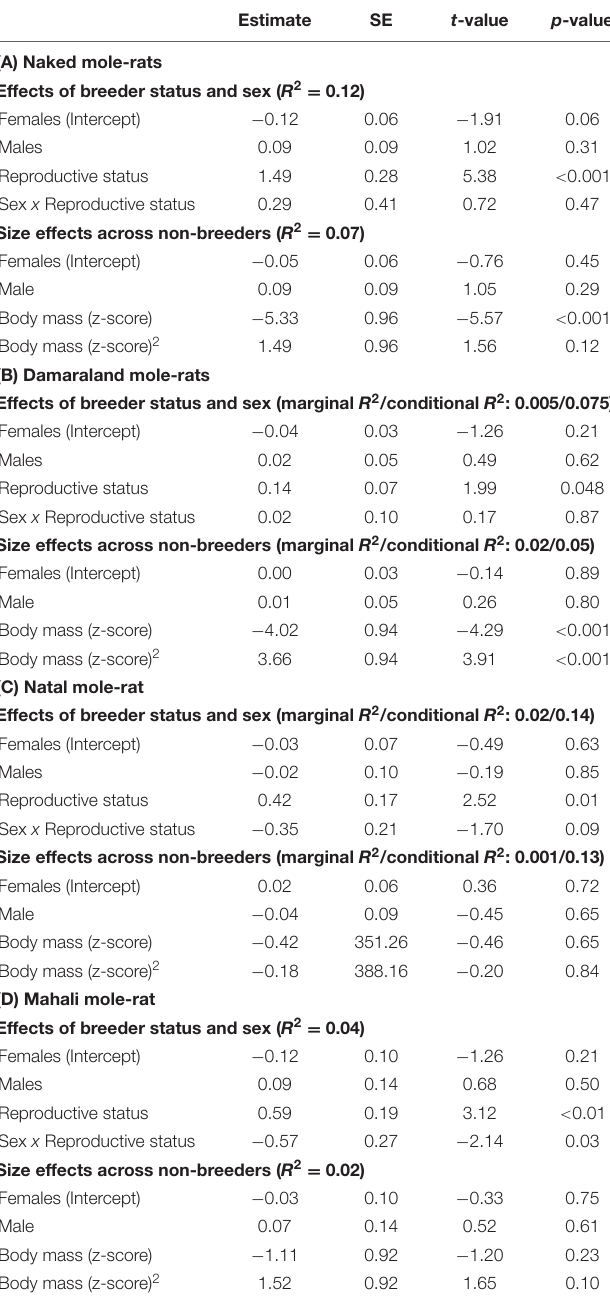
Shown are the estimates, standard error of the mean (SE), t-value, and p-value for (A) naked mole-rats, (B) Damaraland mole-rats (C) Natal mole-rats, and (D) Mahali mole-rats. x denotes interactions between fixed